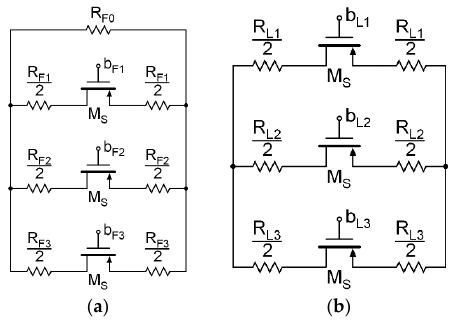
Figure 6. Implementation of ( a ) the feedback resistors, R F , and ( b ) the load resistors, R L